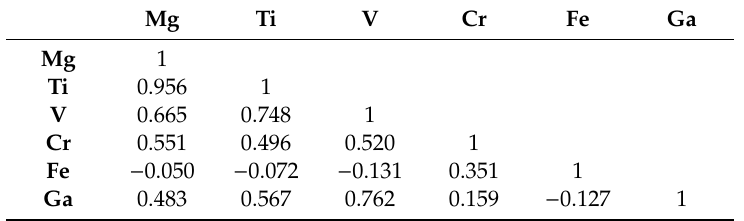
Table 12. Correlation table for trace elements of only blue and violet sapphires from Yogo. Mg Ti V Cr Fe Ga Mg 1 Ti 0.970 1 V 0.697 0.766 1 Cr Ga 0.400 0.376 − 0.018 0.208